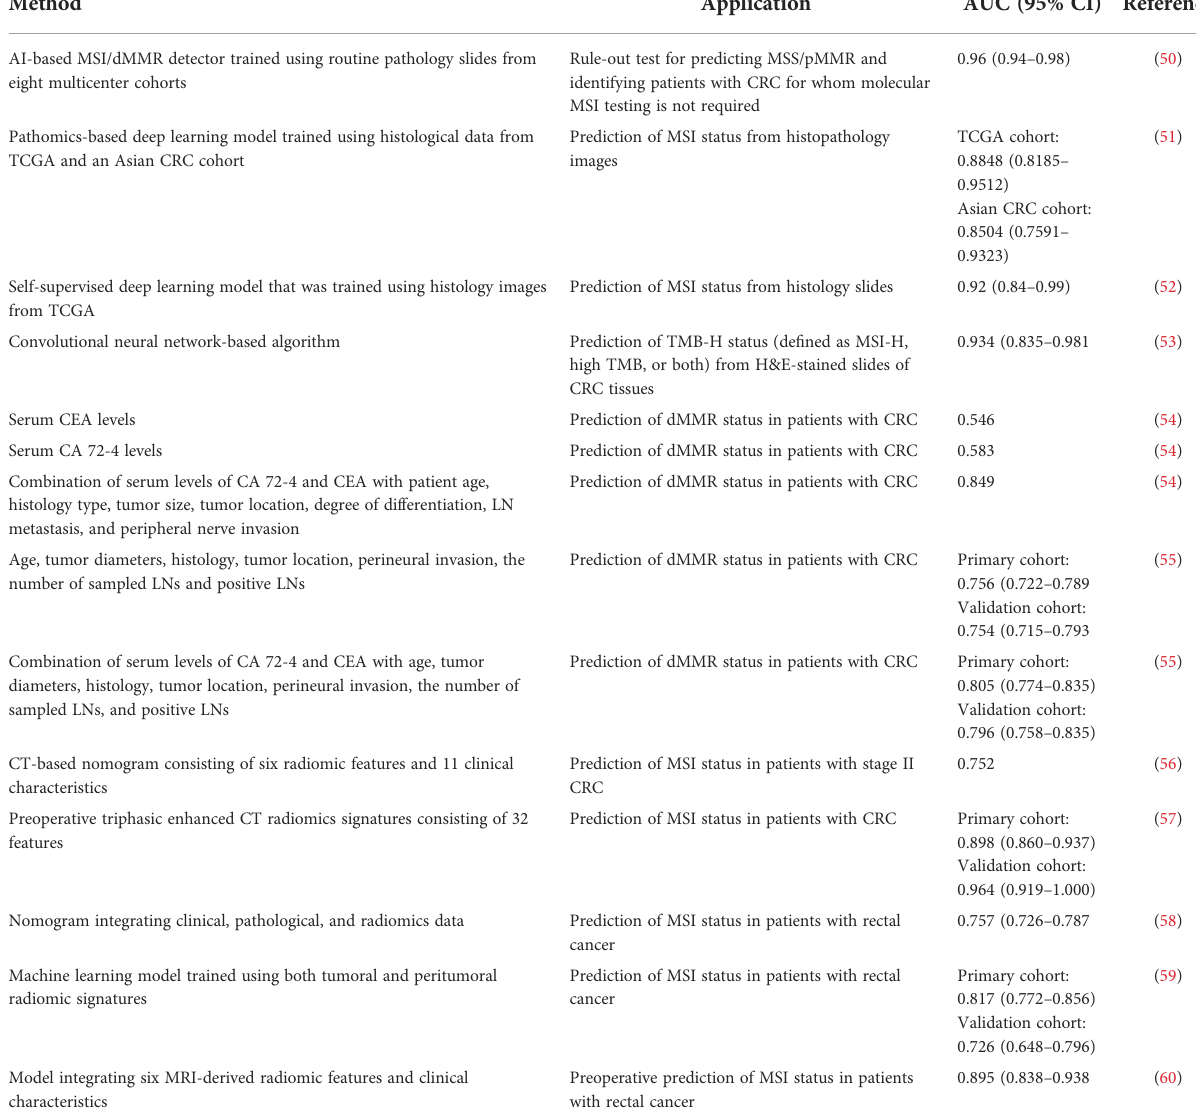
TABLE 1 Emerging non-invasive methods for predicting MSI-H/dMMR status in